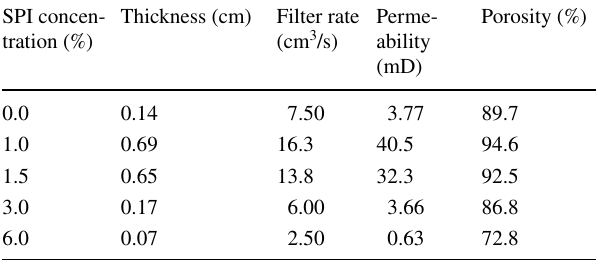
Table 4 Effect of SPI concentration on drilling fluids SPI concen- Thickness (cm) Filter rate tration (%)